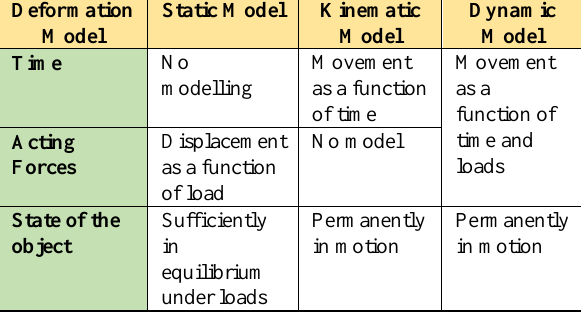
Table 3: Characterization and classification of deformation models (Source: (Ehigiator,